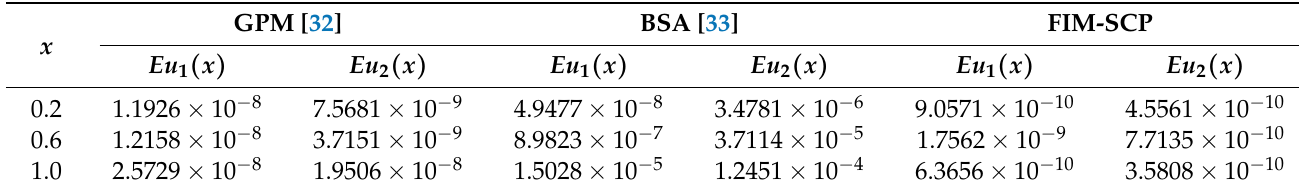
Table 7. A comparison of absolute errors of u 1 ( x ) and u 2 ( x ) for Example 4.